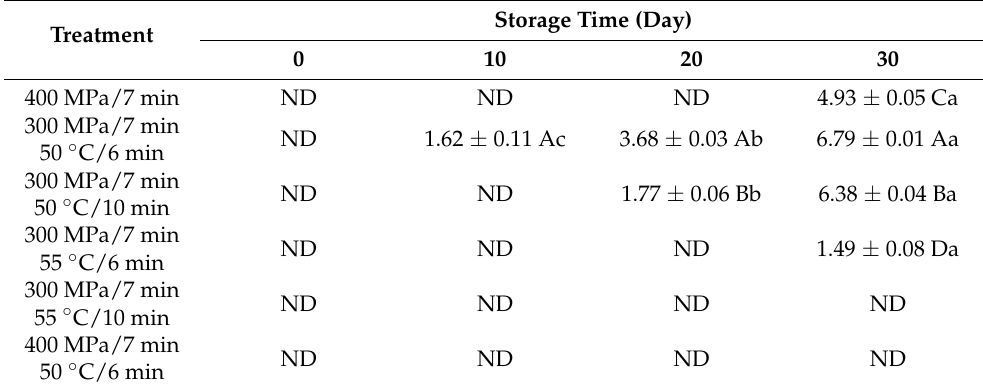
Table 2. Number of total aerobic counts in TAHHP-treated aronia juice during 30 days of storage at